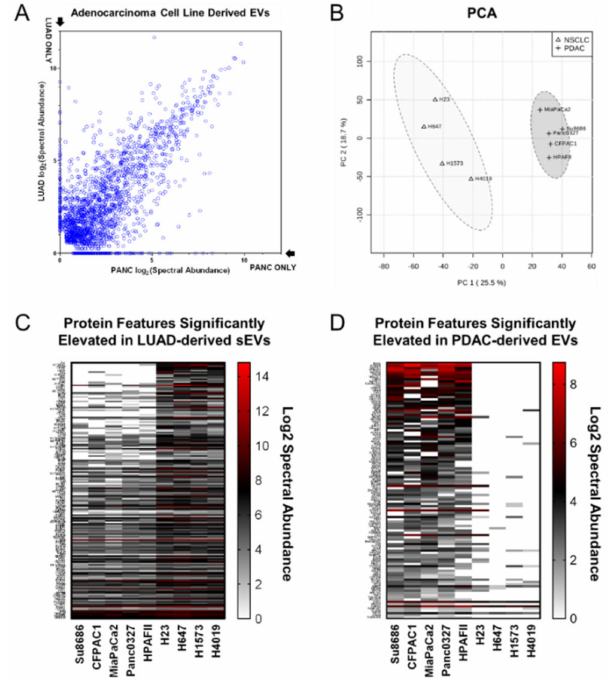
Figure 1. Proteomic profiling of lung and pancreatic ductal adenocarcinoma cell line derived small extracellular vesicles (sEVs). ( A ) Scatter-plot depicting log2 spectral abundance of proteins identified in sEVs from conditioned media of lung (Y-Axis) and pancreatic (X-Axis) adenocarcinoma cell lines. ( B ) Principal component analysis (PCA) of protein features identified in sEVs from conditioned media of lung and pancreatic adenocarcinoma cell lines. ( C ) Heatmap indicating statistically significantly (2-sided student T test p < 0.05) increased protein features in sEVs of lung versus pancreatic adenocarcinoma cell lines. ( D ) Heatmap indicating statistically significantly (2-sided student T test p < 0.05) increased protein features in EVs of pancreatic versus lung adenocarcinoma cell